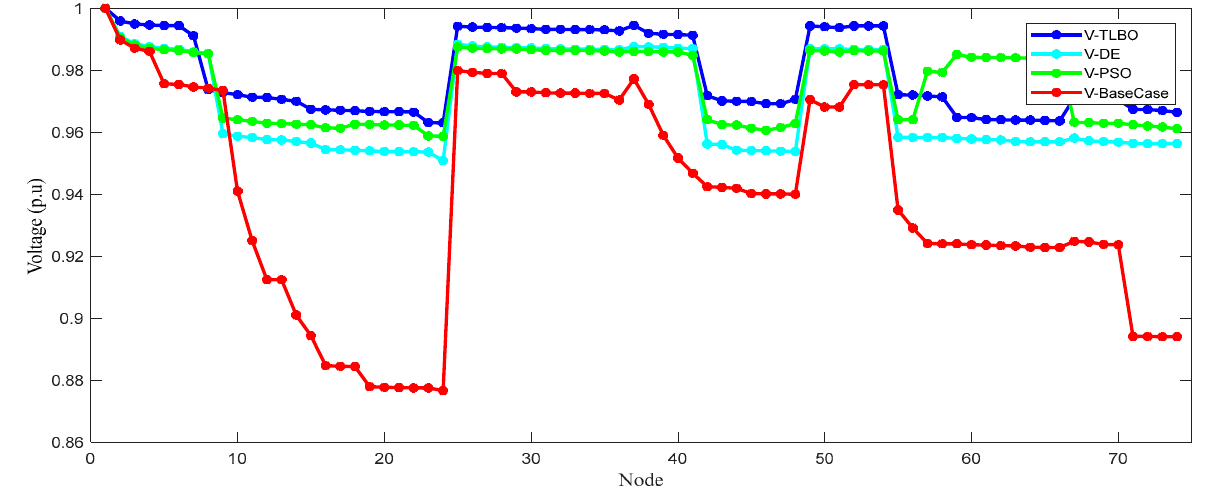
Figure 11. Voltage profile of single fault case considering protection constraints using PSO, DEV, and TLBO.